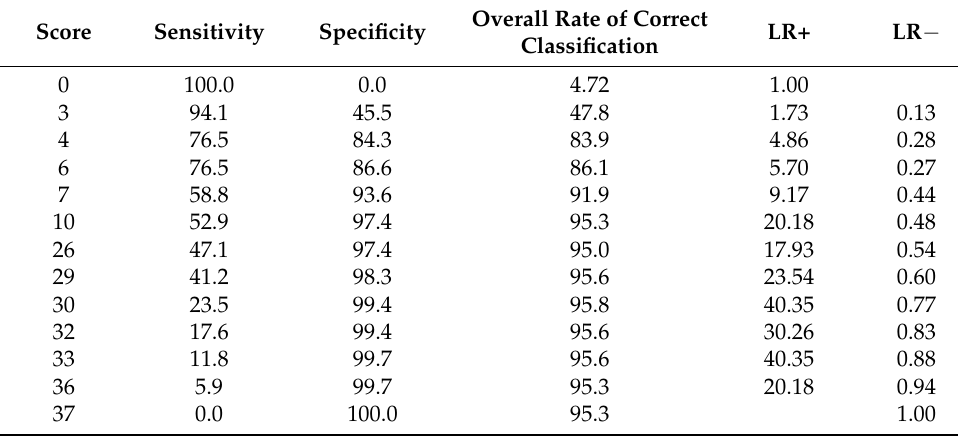
Figure 1. Receiver operating characteristic (ROC) curve in four independent cohorts. Table 4. Prediction parameters for COVID-19 total